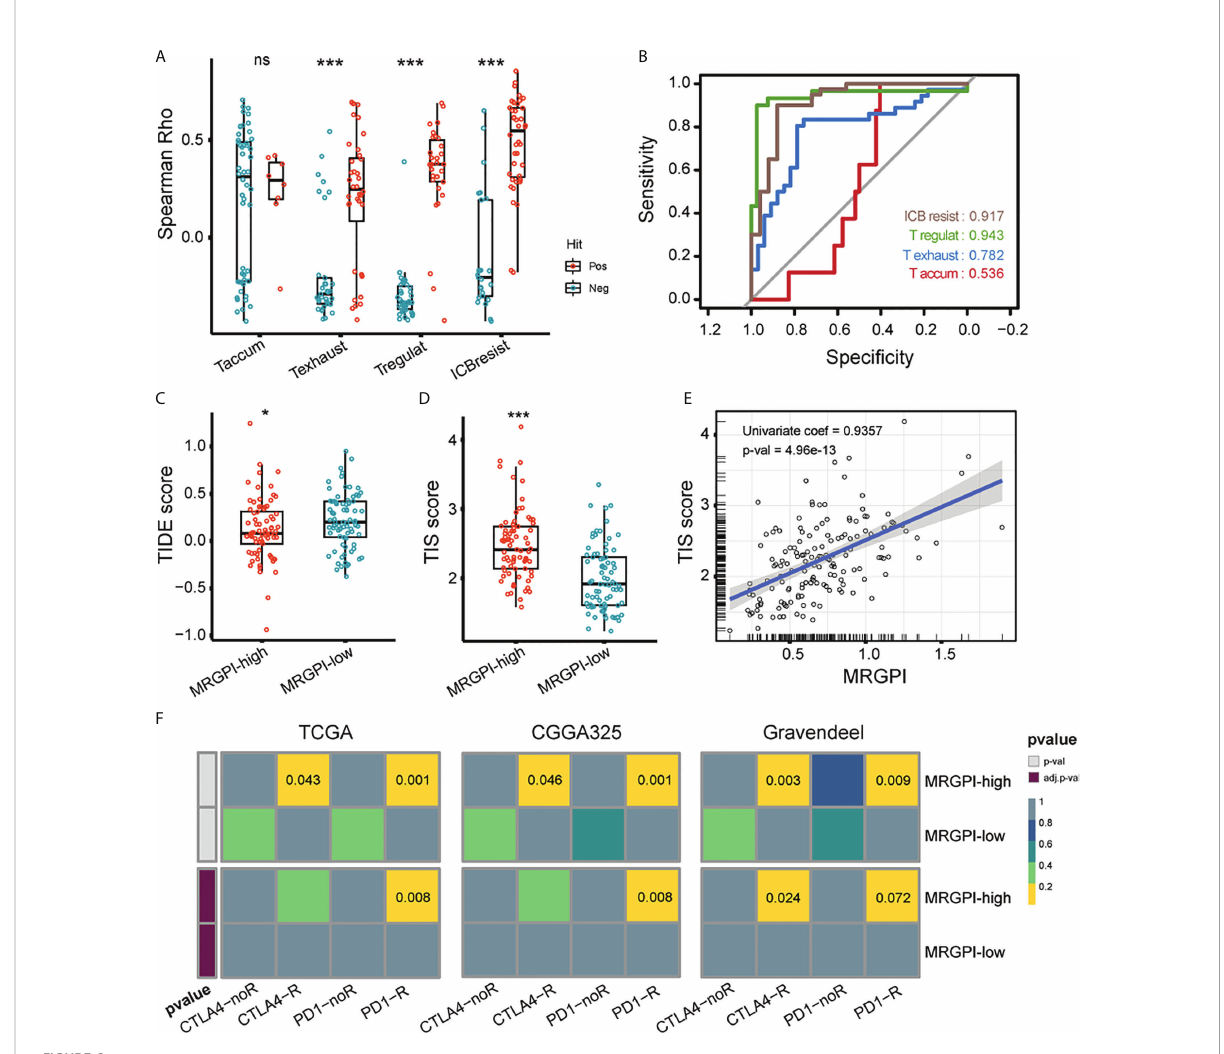
FIGURE 6 Potential of MRGPI in predicting ICB responsiveness. (A) Association between MRGPI and T cell dysfunction-related genes. To achieve this, 4 published gene signatures related to T cell dysfunction were collected and screened. The Spearman rho of positive (red) and negative (green) hit genes with MRGPI was exhibited. The difference in rho between positive and negative groups was compared through the two-sided Wilcoxon test. Taccum, T cell accumulation; Texhaust, T cell exhaustion; Tregulat, regulatory T cell; ICBresist, ICB resistance. (B) ROC curves evaluating the performance of MRGPI in predicting the positive and negative hit gene associated with T cell function. (C) TIDE score between the MRGPI- high and -low groups. (D) TIS score between the MRGPI-high and -low groups. (E) Correlation between the MRGPI and TIS score. (F)